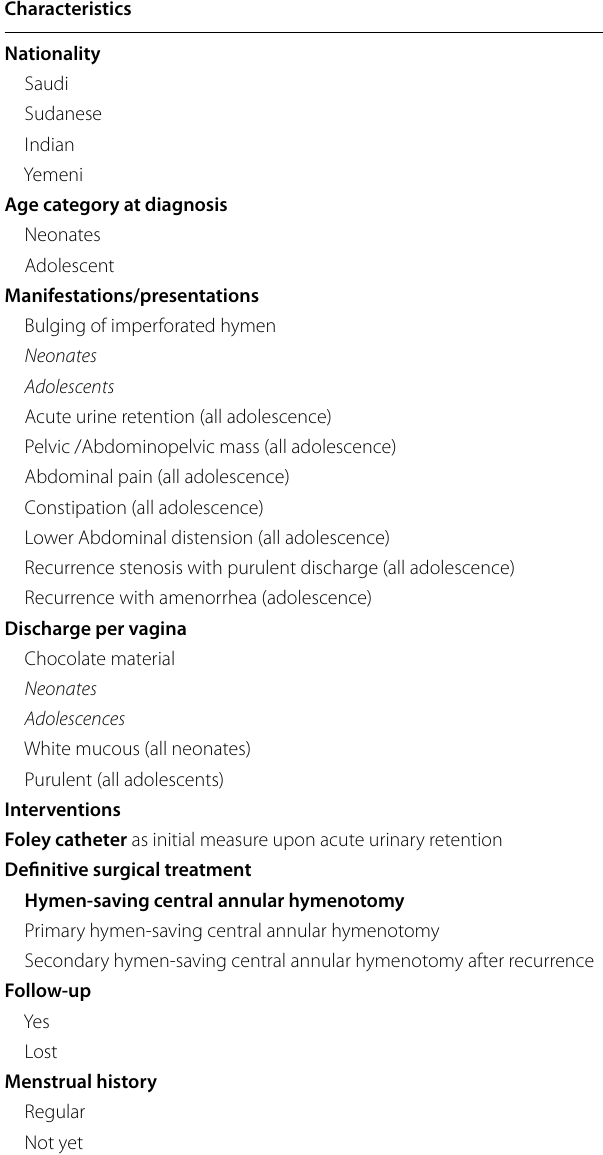
Table 1 Characteristics of patients ( n